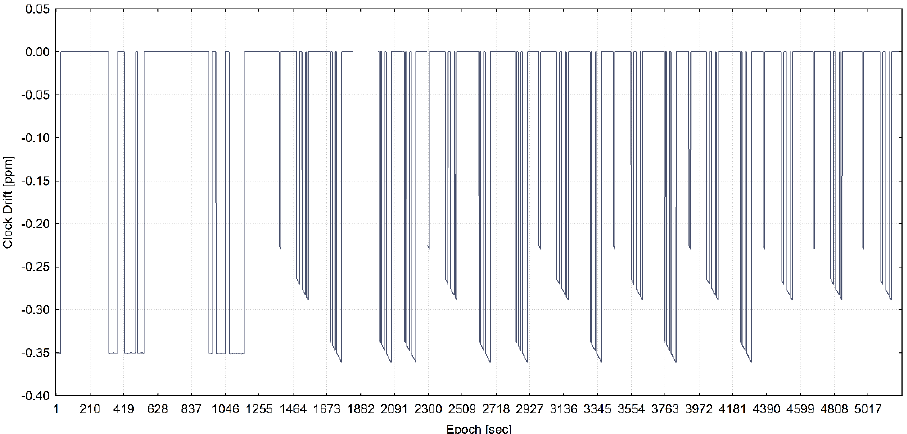
Figure 8. Receiver clock drift from the real-world meaconing dataset (meaconing validation dataset)